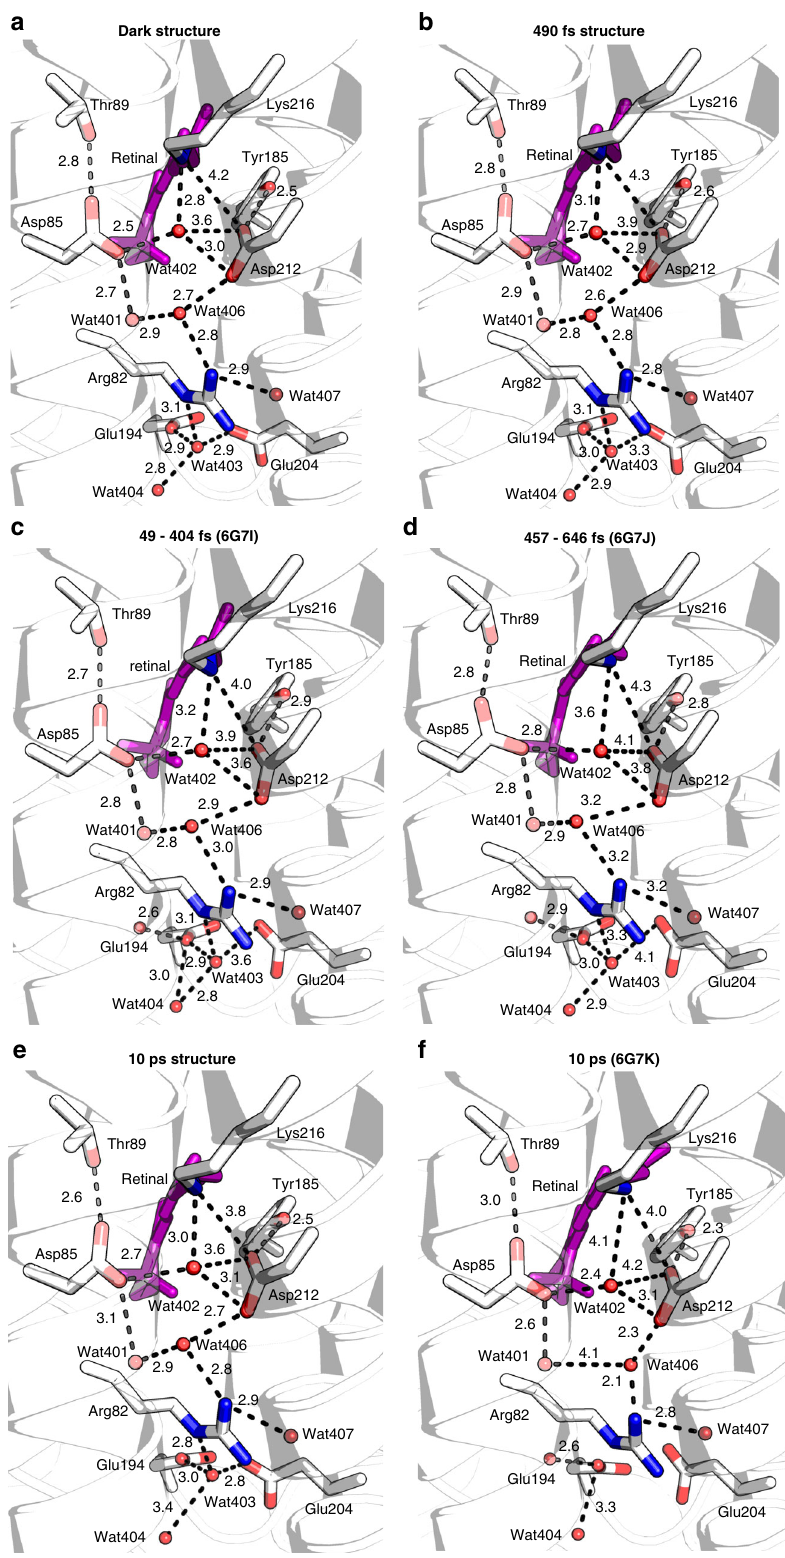
Fig. 10 Evolution of distances between residues and waters along the proton pathway in time. Retinal is shown in pink and waters as red spheres. Distances are given in Å. a Dark-unrestrained structure. b The 490 fs structure. c The 49 – 404 fs structure from Nogly et al. 10 (6G7I). d The 457 – 646 fs structure from Nogly et al. 10 (6G7J). e The 10 ps structure. f The 10 ps structure from Nogly et al. 10 (6G7K). While similar changes in the H-bonding network occur in both studies, the elongation of the retinal protonated Schiff base and water 402 distance is much more pronounced in the Nogly et al. 10 work, as well